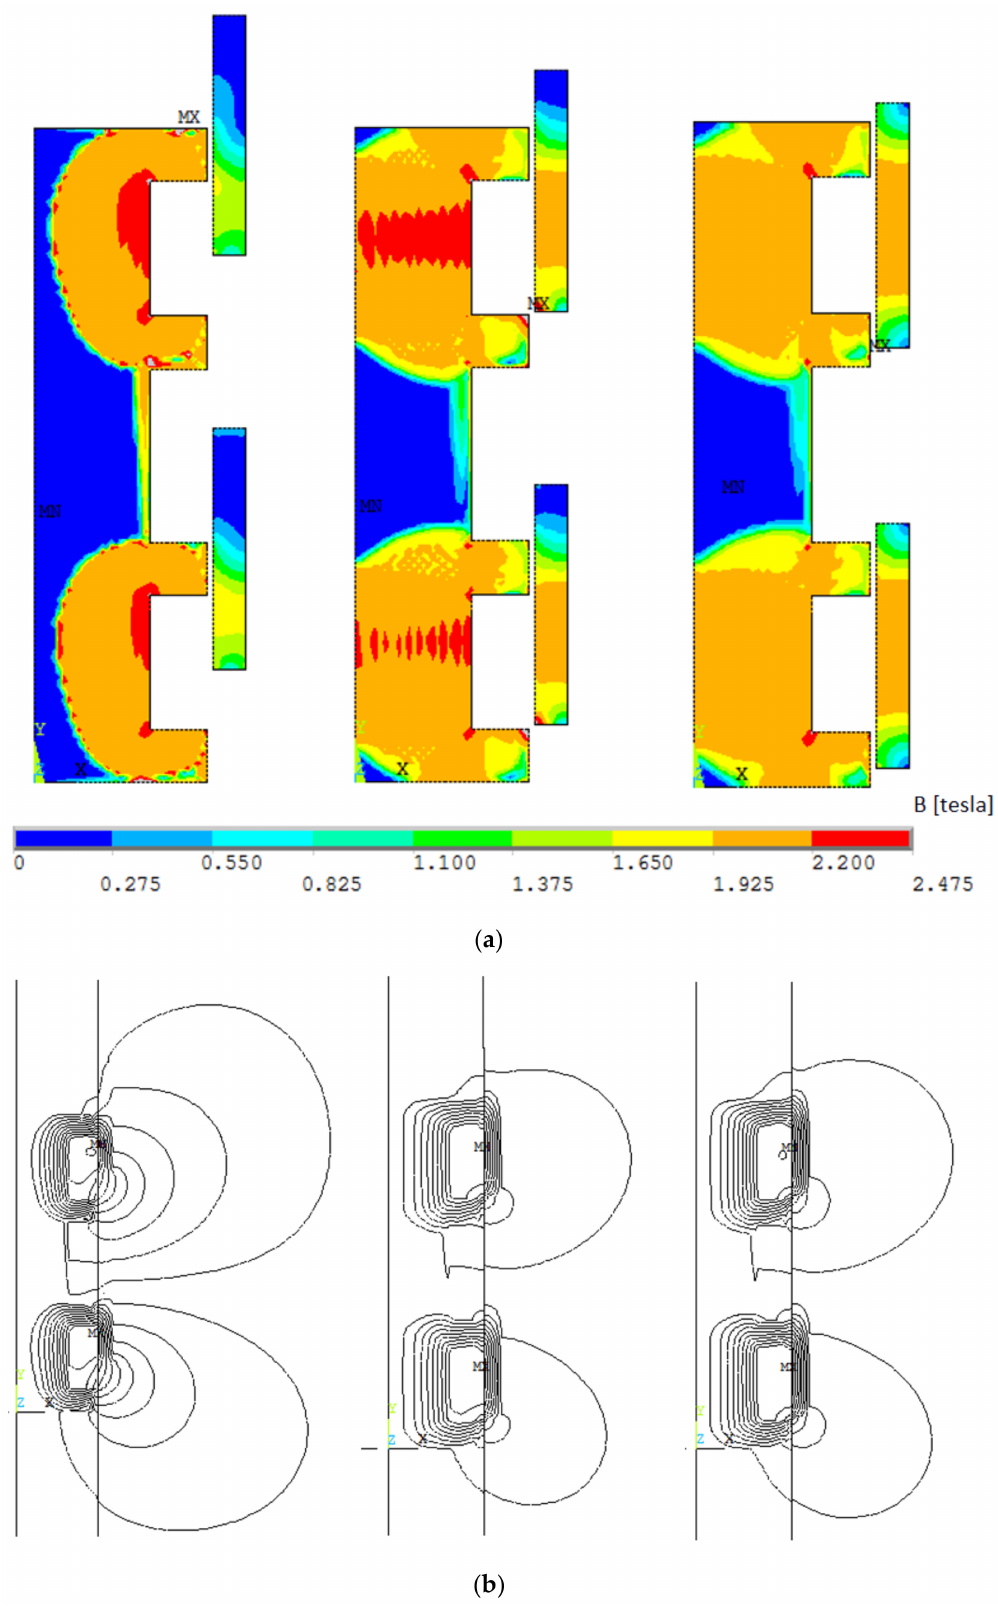
Figure 22. Magnetic field ( a ) and magnetic field lines ( b ) for hammer displacement (from the left): 1 mm, 2.5 mm and 4 mm—Variant